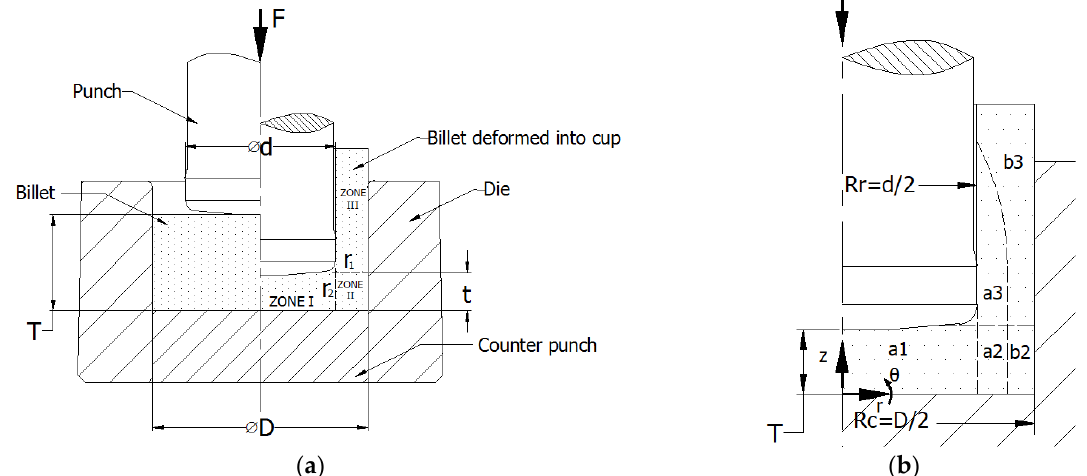
Figure 20. ( a ) Three-zone representation of the cold forging backward extrusion process. ( b ) Strain distribution areas for the three-zone representation.